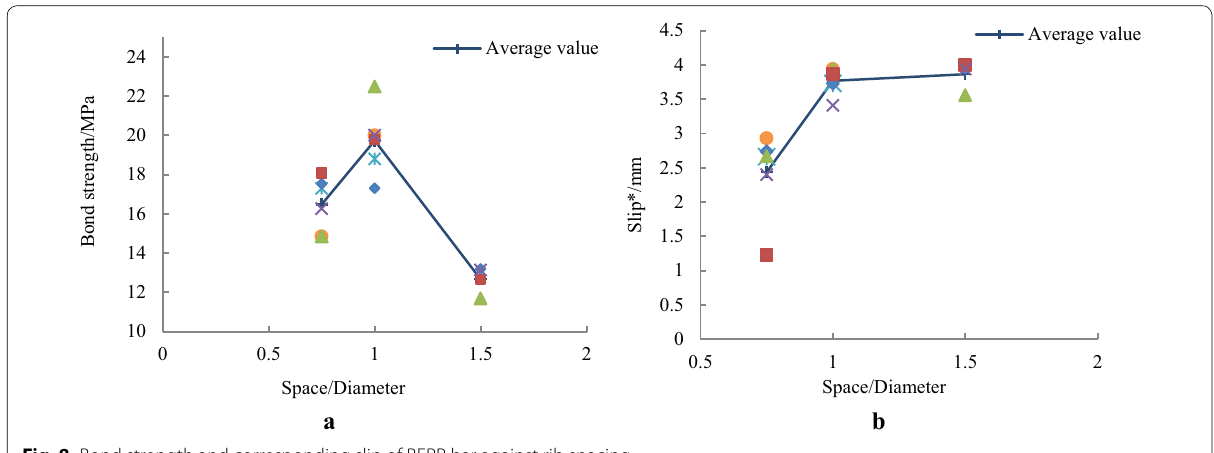
Fig. 8 Bond strength and corresponding slip of BFRP bar against rib